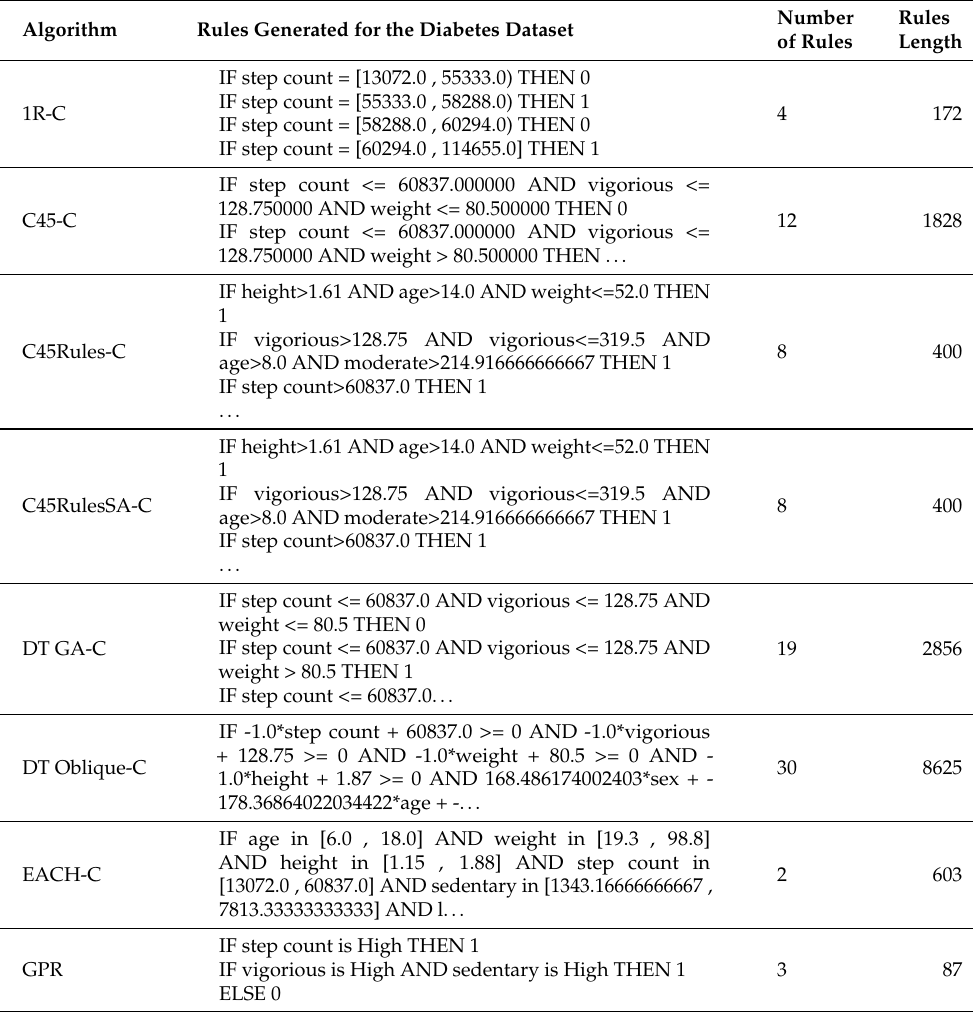
Table 4. Example of “if-then” fuzzy rules generated by fuzzy rule-based classifiers on the real Diabetes